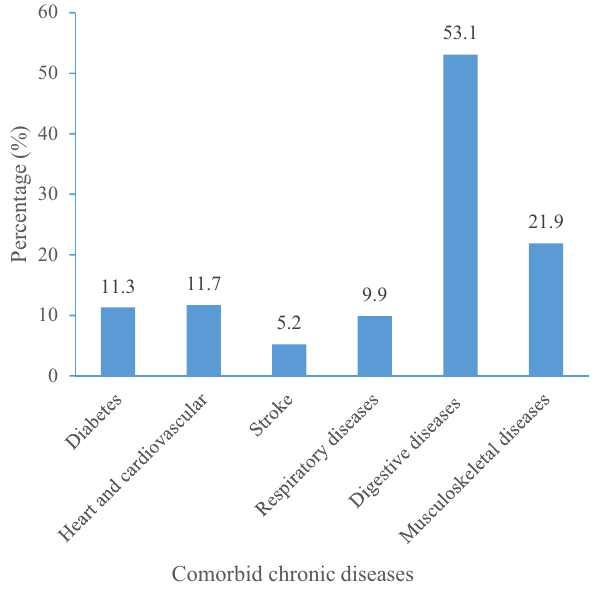
Figure 1. Percentage of BCSs with comorbid chronic diseases.